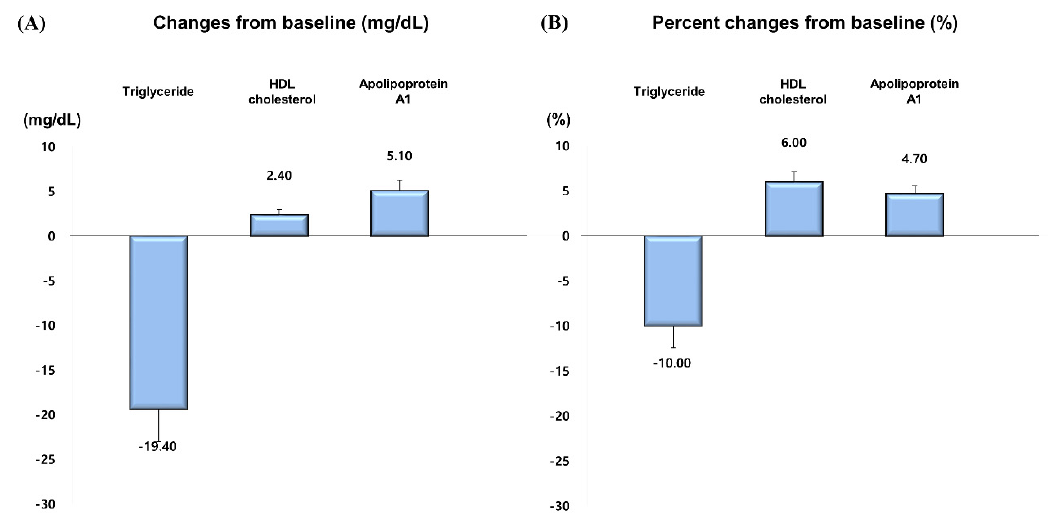
Figure 3. Changes in triglyceride, HDL cholesterol and apolipoprotein A1 in 8 weeks. ( A ) Changes from baseline. ( B ) Percent changes from baseline.